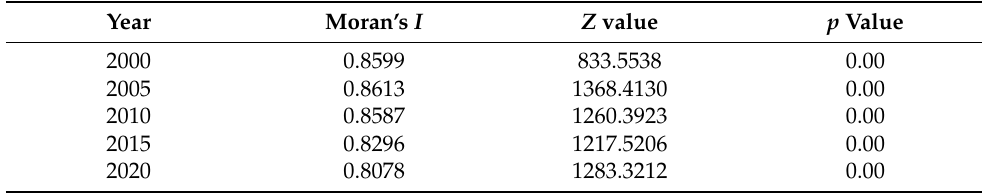
Table 7. Moran’s I in Ruijin City from 2000 to 2020.